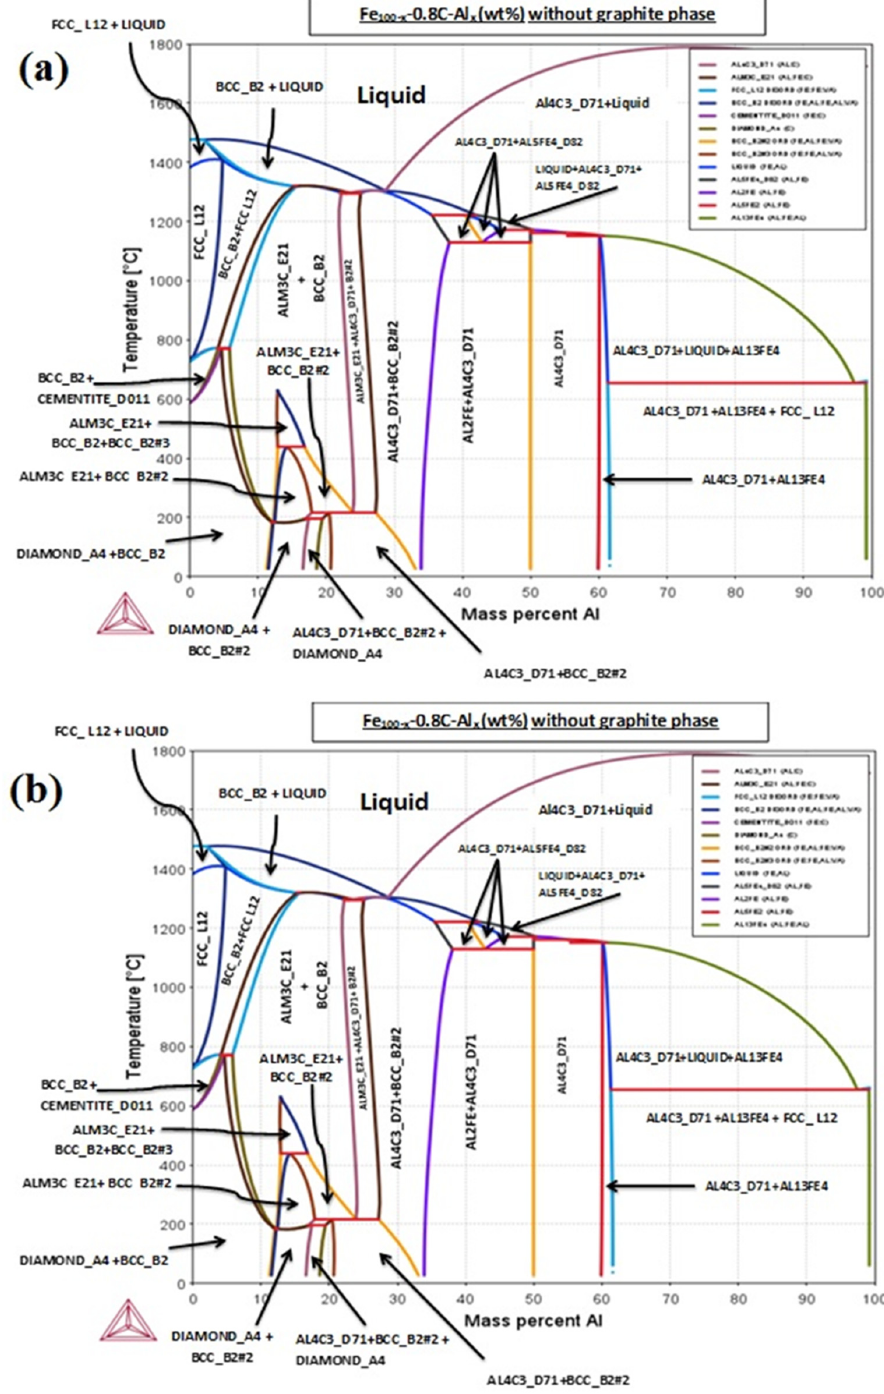
Figure 13. ThermoCalc® software phase diagram of ( a ) ferrite composition (Fe with 0.01 C%) of Aluminum and ( b ) the perlite composition for Fe with 0.8 C% Aluminum, without graphite formation.